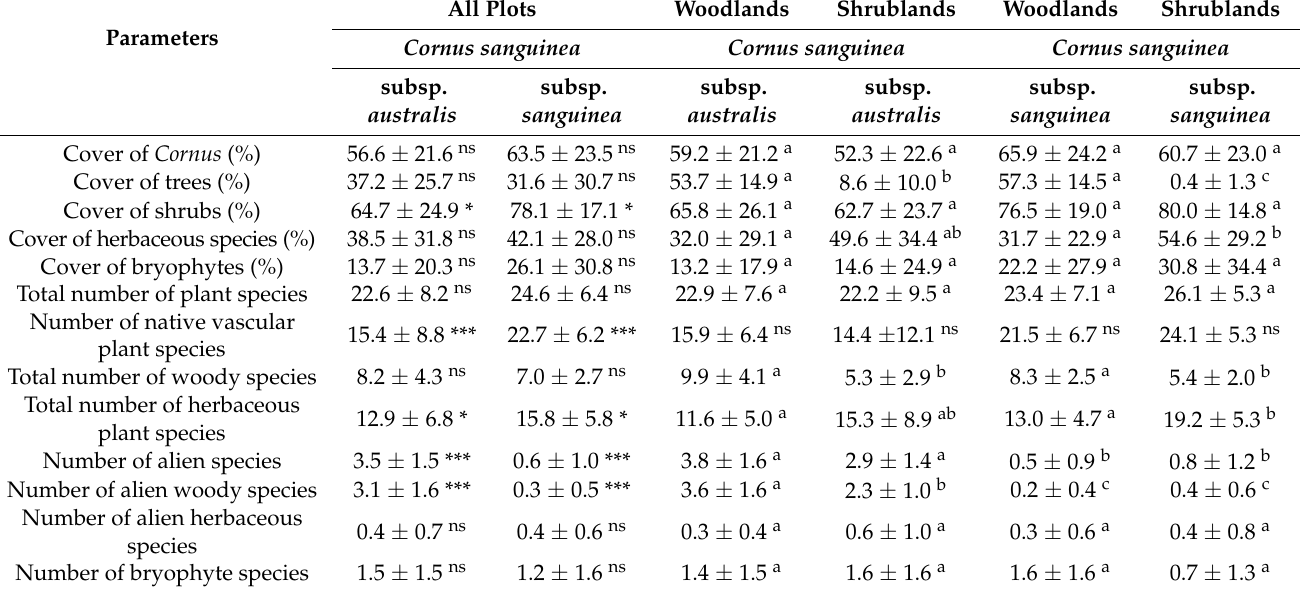
Table 4. Statistical comparison of the characteristics (mean ± standard deviation) of the plant communities in the study plots with Cornus sanguinea subsp. australis and Cornus sanguinea subsp. sanguinea . Differences between all study plots were determined with a two-sample Mann–Whitney performed applying the Mann–Whitney pairwise comparison and different letters indicate significant differences between the two